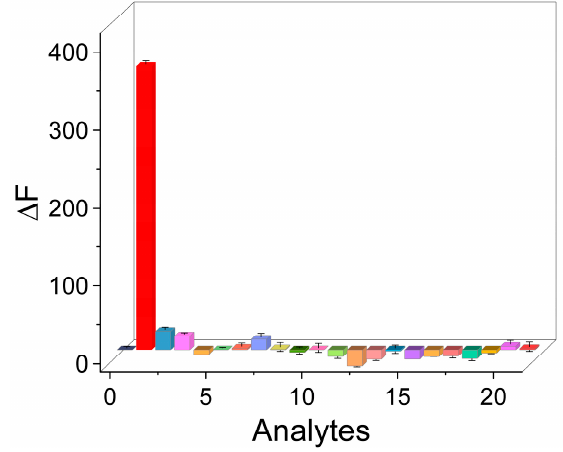
Figure 5. Specificity of the developed detection method for AQ4N. The labels of number marked on the X-axis correspond to (0) blank, (1) AQ4N, (2) Fe 2+ , (3) Fe 3+ , (4) Zn 2+ , (5) Mg 2+ , (6) K + , (7) Na + , (8) HCO 3- , (9) GSH, (10) His, (11) BSA, (12) Ca 2+ , (13) NAC, (14) CAR, (15) AA, (16) glucose, (17) urea, (18) Cys, (19) DDP, (20) alizarin, and (21) rhein. The concentrations of AQ4N and BSA were set at 0.5 µ M and 40 µ g/mL, respectively. The concentrations of alizarin and rhein were 1 µ M. The concentrations of other tested substances were 10 µ M. Table 1. Detection of AQ4N in mouse